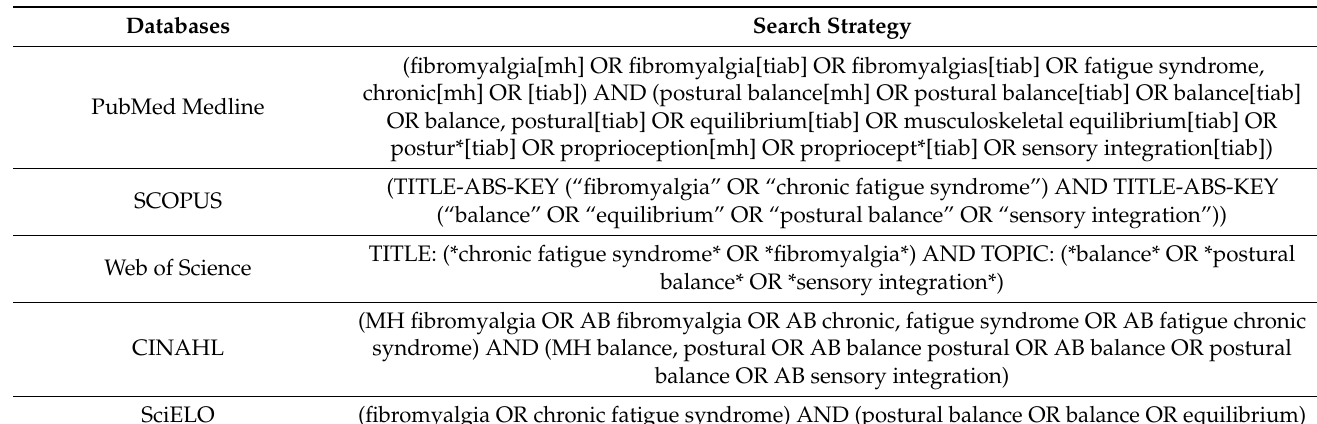
Table 1. Bibliographic search strategy used in each